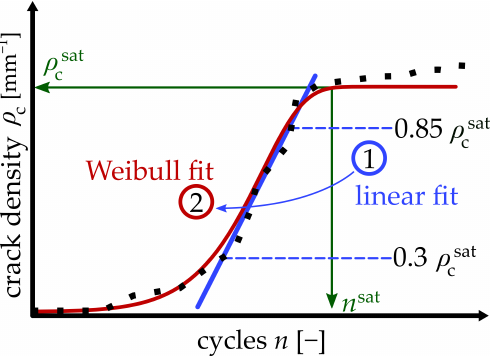
Figure 3. The experimentally obtained crack densities are fitted with a two-step approach. The first step is a linear regression from 30% to 85% of the saturation crack density. In the second step, a cumulative Weibull distribution function is fitted to the linear